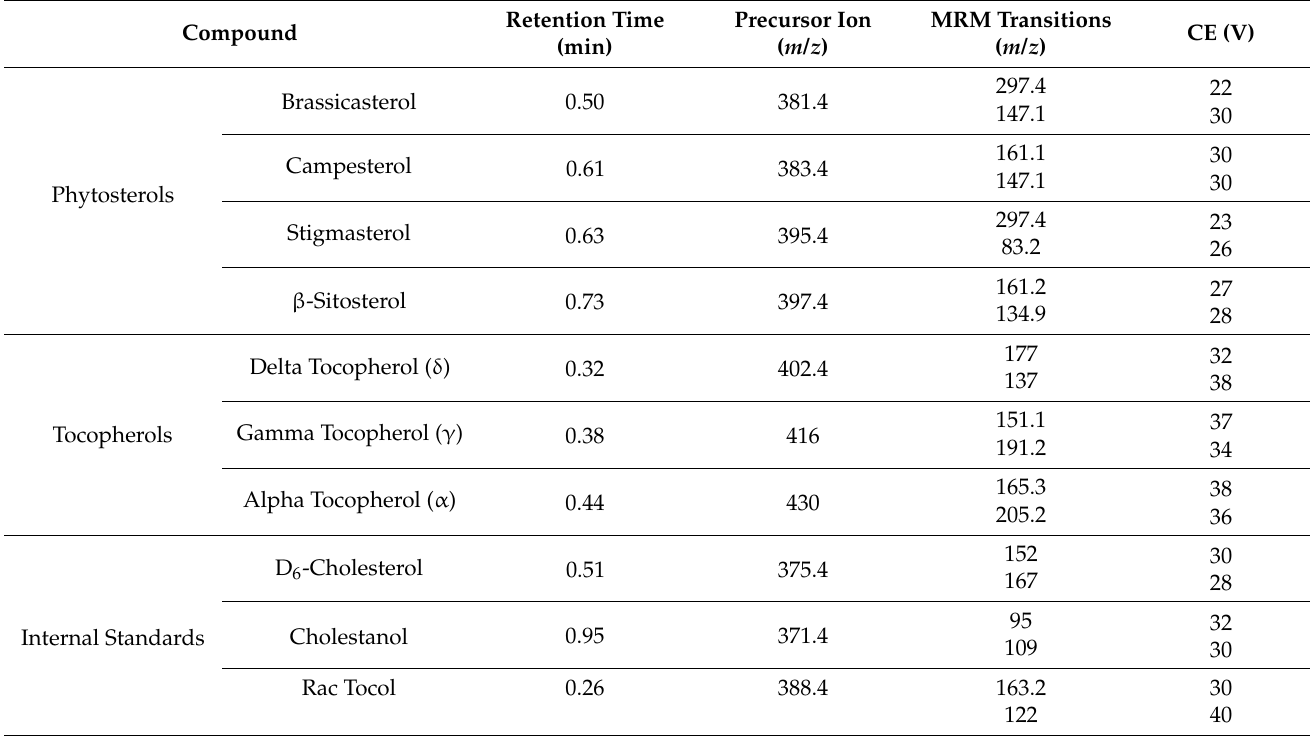
Table 2. The mass transitions, collision energy (CE), and retention times of all target compounds including the internal standards. Declustering potential (DP) of 40 V was applied to all